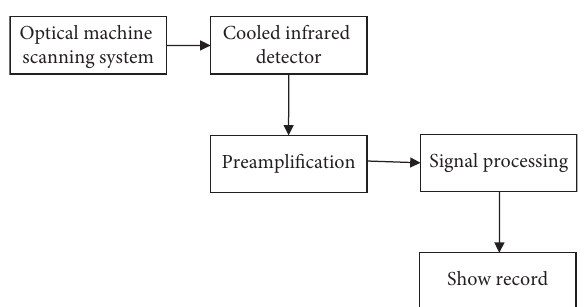
Figure 1: Block diagram of the principle of the infrared thermal imager based on optical mechanical